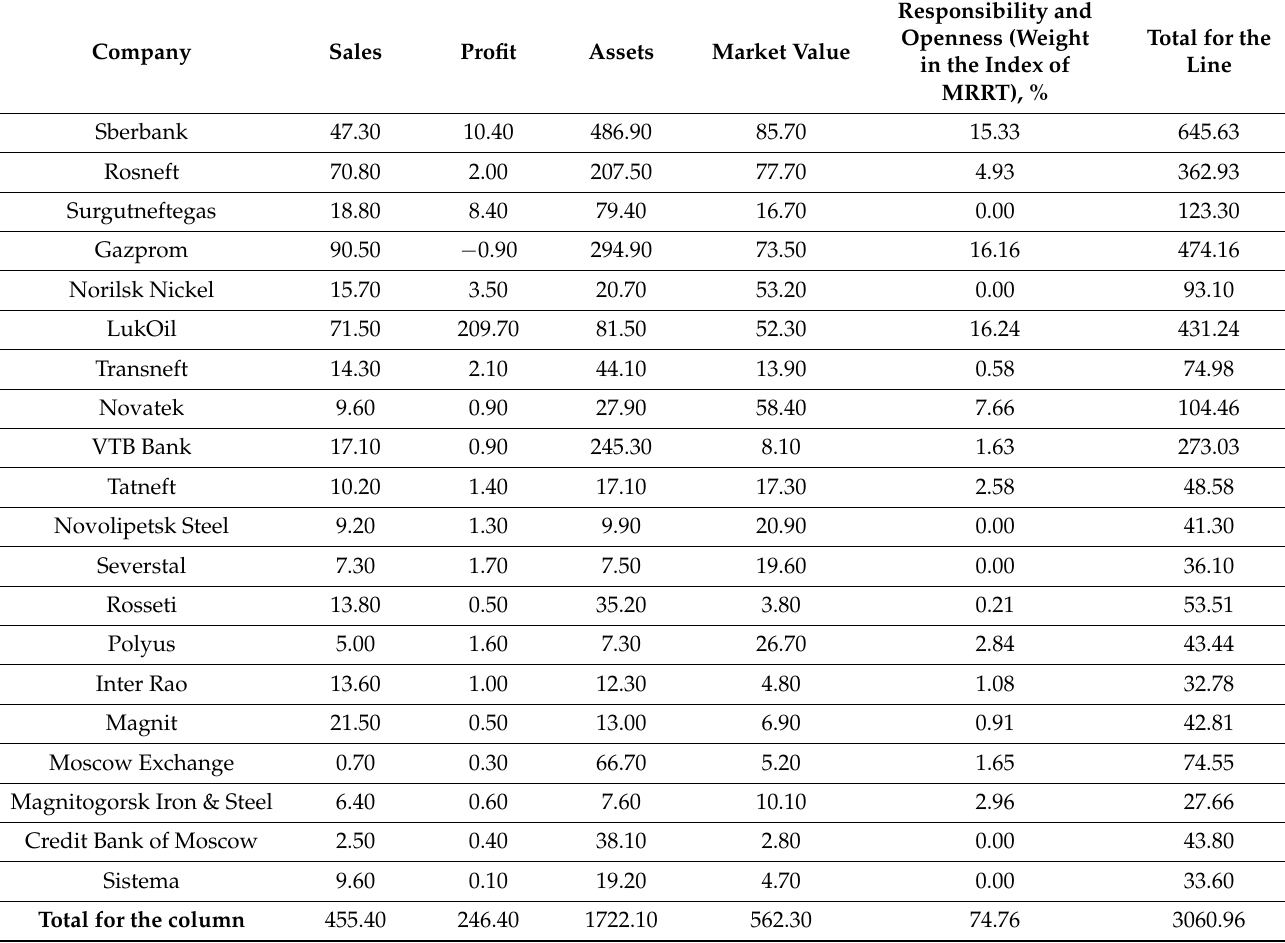
Table A1. Observed values of five variables in 2021.